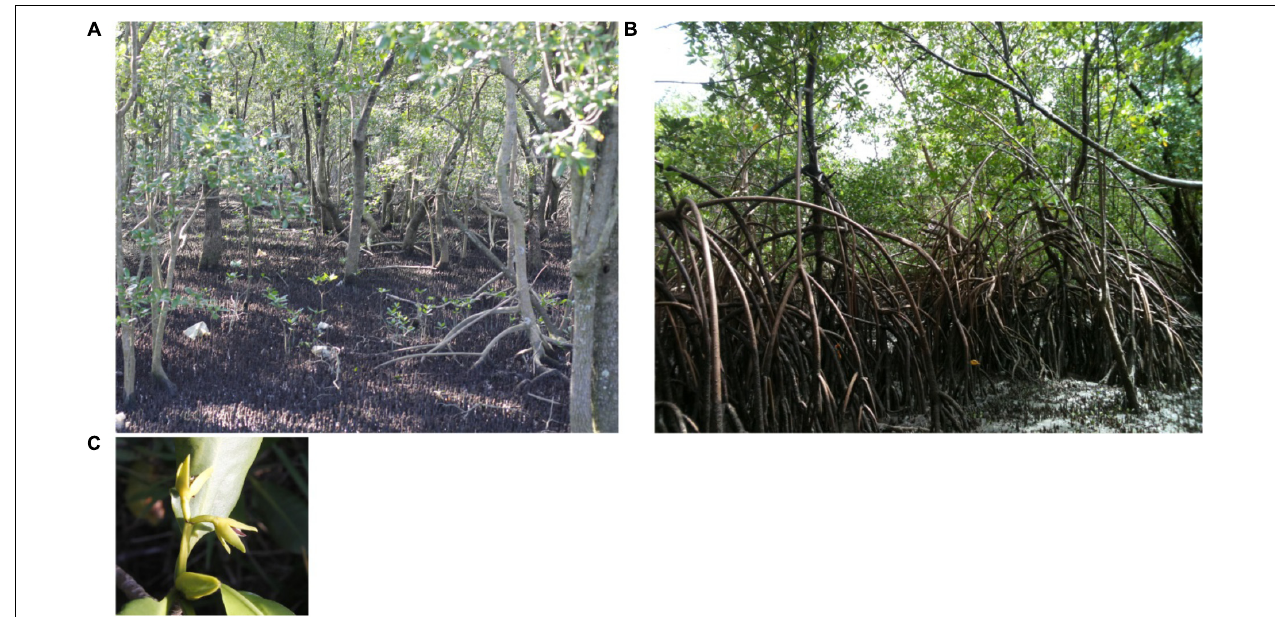
FIGURE 2 | Phenotypic divergence between Rhizophora mangle L. at both sampling sites and species-specific floral traits. (A) A mangrove forest in the subtropical sampling site, where the distribution of individuals is sparse, and the prop roots of R. mangle do not reach 1 m in height. (B) An R. mangle -dominated forest along the equatorial coast of South America, where the prop roots reach up to 5 m in height. (C) A floral branch of R. mangle , showing the axillary inflorescence grouped into two branches, which is a characteristic used for species identification.